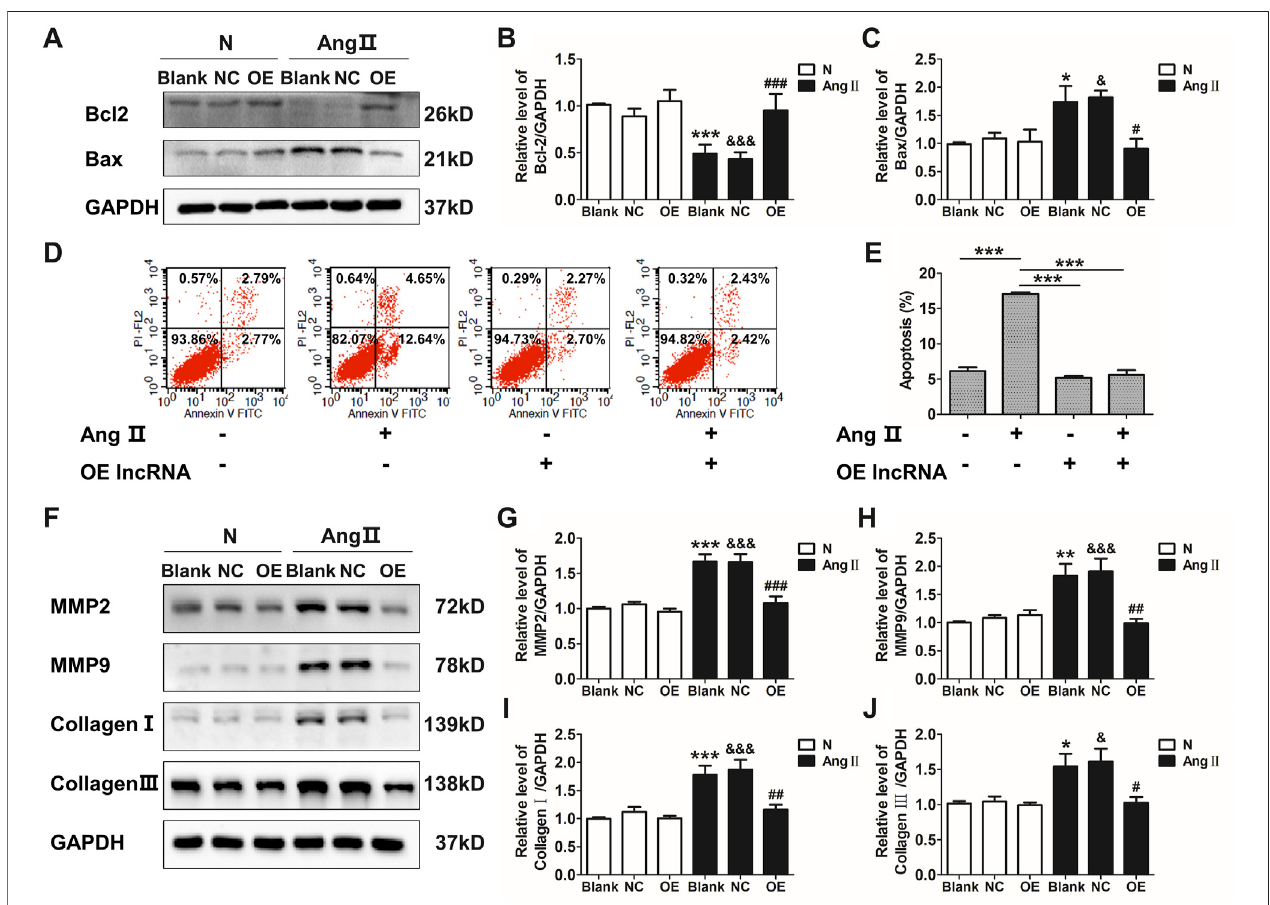
FIGURE 3 | Overexpression of lnc-C2orf63-4-1 attenuates the AngII-induced apoptosis, fi brosis, and MMP-2/9 activity in VSMCs. (A – C) Lnc-C2orf63-4-1 reducedtheexpressionofBaxandincreasedtheexpressionofBcl-2inmouseVSMCsfollowingAngIItreatment( n (cid:1) 6/pergroup). (D,E) Apoptosisanalysisexaminedby fl owcytometryusingAnnexinV/PIassay( n (cid:1) 4/pergroup). (F – J) RepresentativeWBsandquanti fi cationresultsofMMP-2,MMP-9,typeIcollagenandtypeIIIcollagenin the mouse VSMCs treated with orwithoutlnc-C2orf63-4-1 after AngIItreatment( n (cid:1) 6/pergroup). GAPDH wasused for normalization. Datawereall compared by analysis-of-variance (ANOVA) with Bonferroni ’ s post-test. * p < 0.05, ** p < 0.01, *** p < 0.001 vs. blank group, # p < 0.05, ## p < 0.01, ### p < 0.001 vs. AngII group, & p < 0.05, &&& p < 0.001 vs. AngII + OE-lnc-C2orf63-4-1 group. Data were all expressed as mean ± SEM.